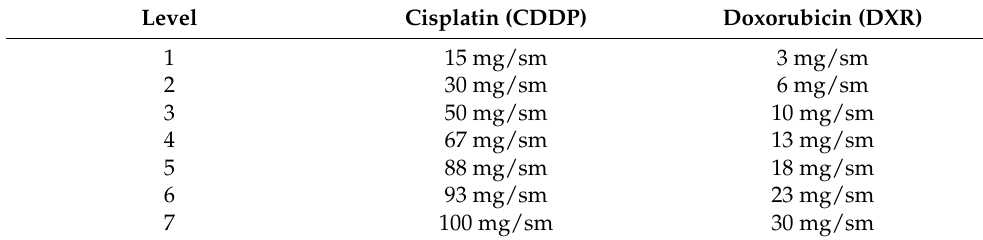
Table 1. Cisplatin and doxorubicin dose escalation